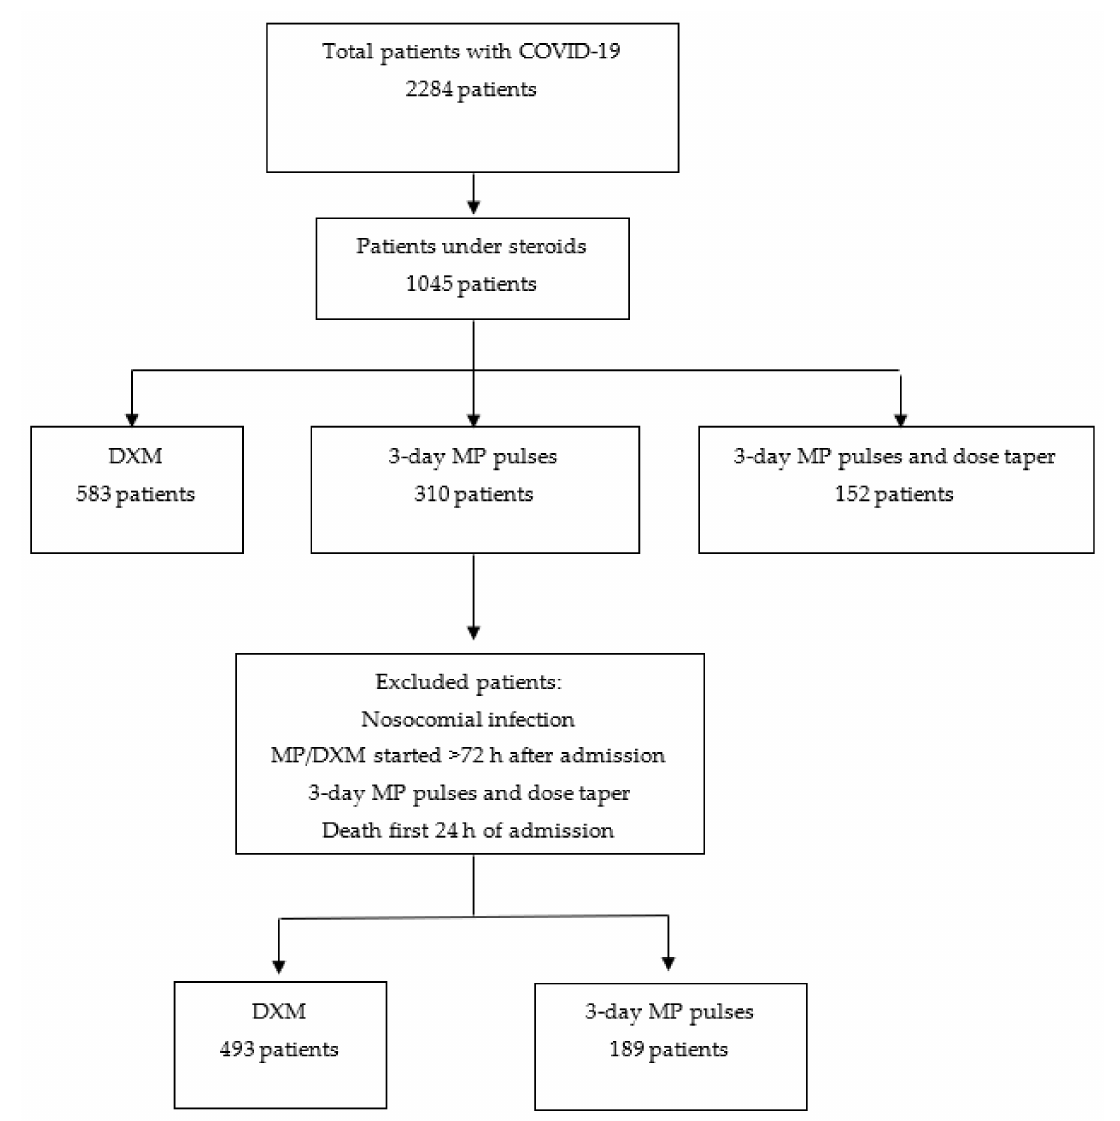
Figure 1. Flow-Chart. DXM: dexamethasone. MP: methylprednisolone. Table 1 shows the comparison of the demographic and comorbidity data between MP and DXM groups. The median age was similar between groups, with a significant predominance of males in the MP group, being Caucasian in the majority of the overall included patients. There was a small difference between groups in the days between the disease onset and the hospital admission (MP 8 vs. DXM 7 days, p = 0.011). The main comorbidities were arterial hypertension, dyslipidemia and diabetes